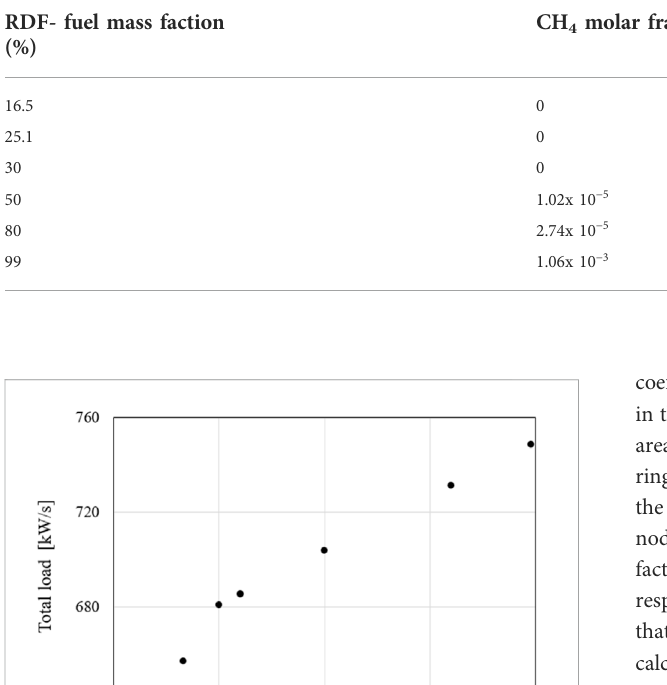
TABLE 9 Molar fractions of methane and carbon monoxide in the fl ue gas.